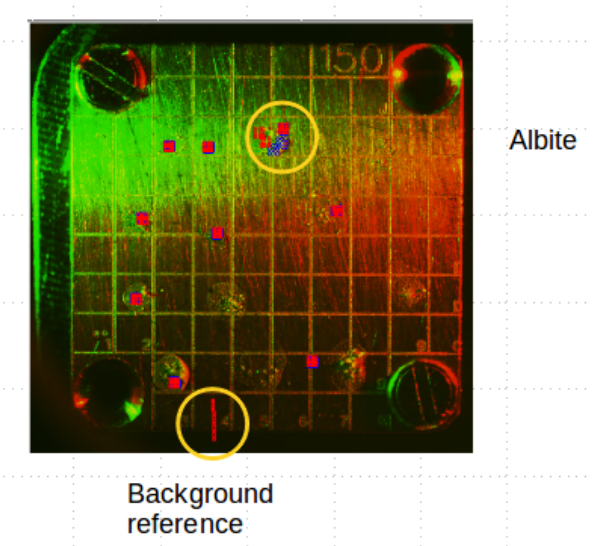
Figure 1. A substrate to collect dust. This one contains multiple mineral samples. In the middle at the top the albite mineral is de- posited and a 5 × 5 matrix of closely spaced measurements is made. At the bottom is a straight vertical matrix of measurements on a clean area of the substrate which serves as a background reference.